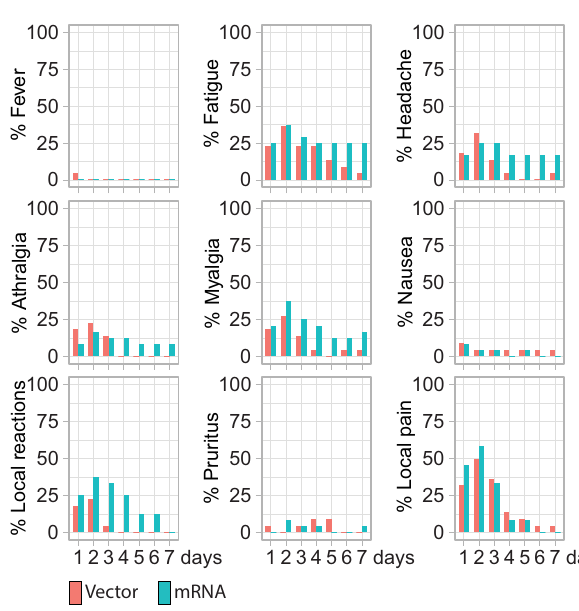
Fig. 5 | Safety. Local and systemic reactogenicity evaluated daily during the fi rst 7 days after